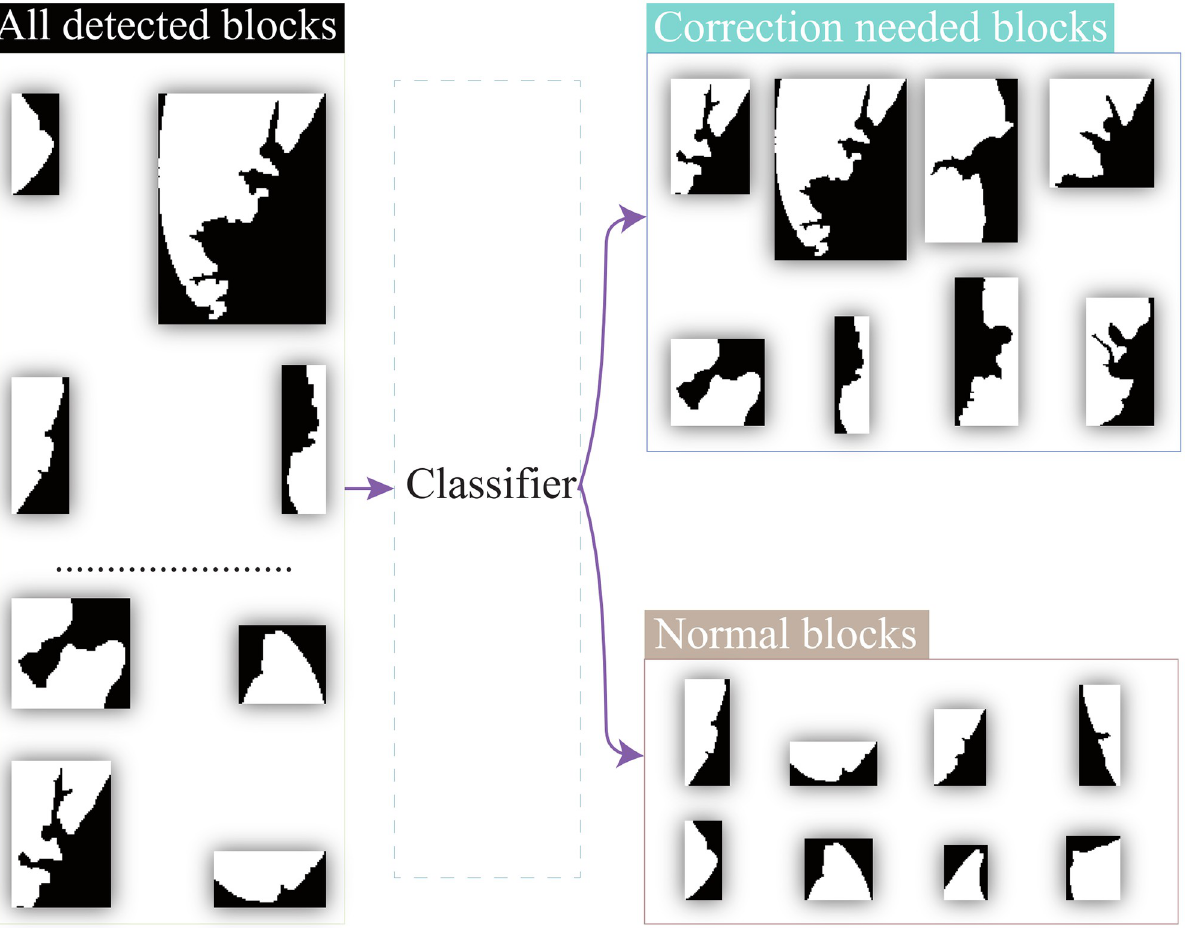
Fig 8. Classification of the two types of blocks.